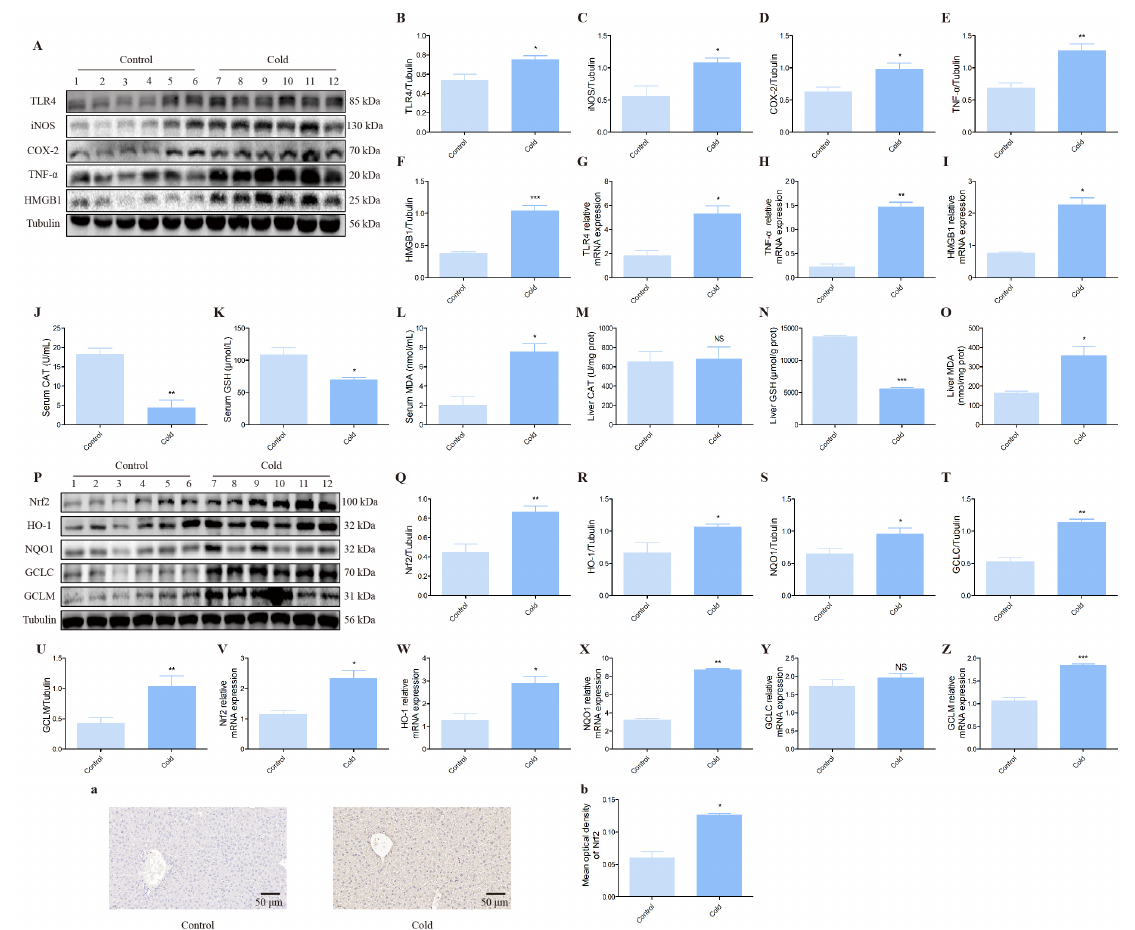
Figure 3. Effect of cold stress on inflammatory cytokines expression, oxidative stress-related in- dexes and protein levels assessed by Western blot and ELISA. ( A ) TLR4, iNOS, COX-2, TNF- α , HMGB1 and Tubulin protein levels in each group. ( B – F ) Quantification of expression levels based on expression ratios of TLR4/Tubulin, iNOS/Tubulin, COX-2/Tubulin, TNF- α /Tubulin and HMGB1/Tubulin. ( G – I ) The histograms of relative mRNA analysis of TLR4/ β -actin, TNF- α / β -actin and HMGB1/ β -actin. ( J – L ) The enzyme activity of CAT, GSH and content of MDA in the serum of control and cold groups. ( M – O ) The enzyme activity of CAT, GSH and content of MDA in the liver of control and cold groups. ( P ) Nrf2, HO-1, NQO1, GCLC, GCLM and Tubulin proteins levels in each group. ( Q – U ) Quantification of expression levels based on expression ratios of Nrf2/Tubulin, HO-1/Tubulin, NQO1/Tubulin, GCLC/Tubulin and GCLM/Tubulin. ( V – Z ) The histograms of rela- tive mRNA analysis of Nrf2/ β -actin, HO-1/ β -actin, NQO1/ β -actin, GCLC/ β -actin and GCLM/ β - actin. ( a ) Immunohistochemical scans of Nrf2. (Scale bar = 50 µ m). ( b ) Average optical density values of Nrf2 proteins. Data are presented as mean ± standard ( n = 6). NS means not significant, * p < 0.05, ** p < 0.01, *** p <